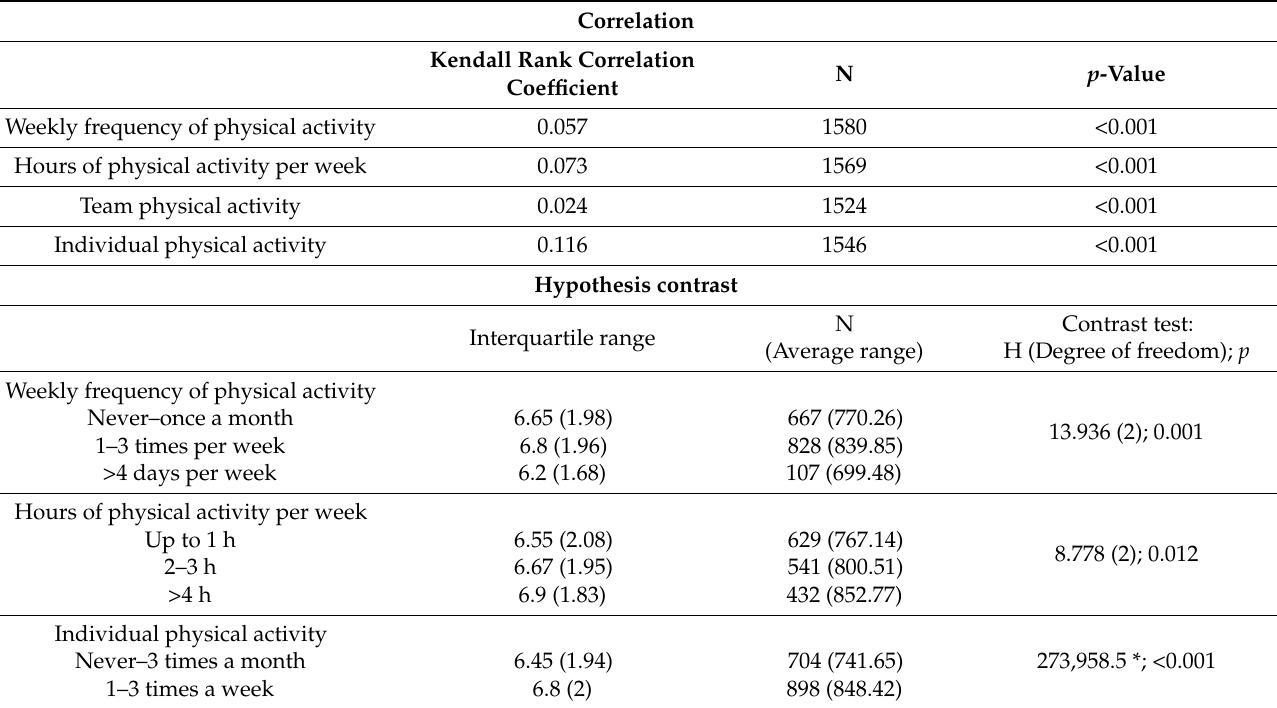
Table 3. Relationship between physical activity and academic